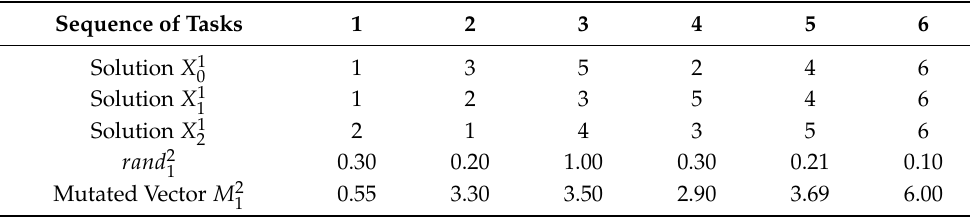
Table 2. An illustrative example of a mutant vector creation. Sequence of Tasks